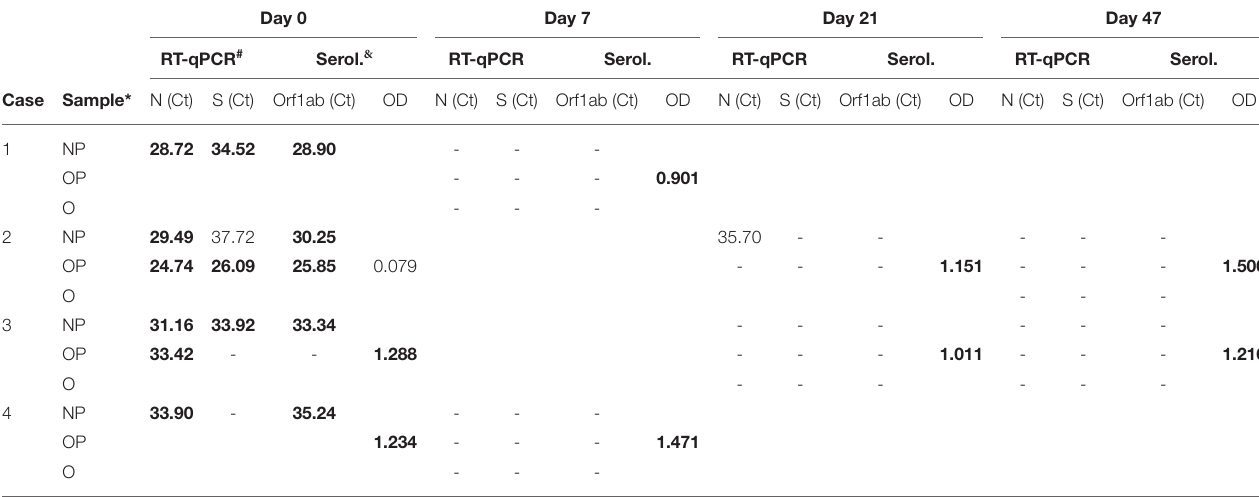
TABLE 2 | SARS-CoV-2 detection by RT-PCR and serology